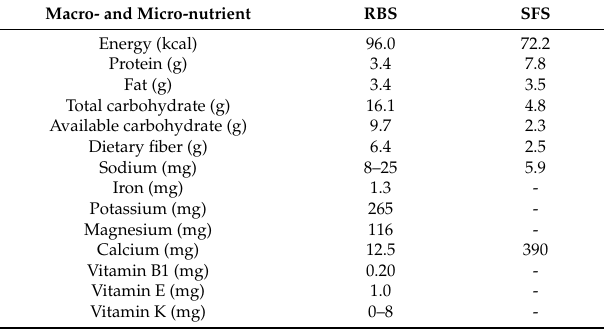
Table A1. Macro- and micro-nutrient composition of rice bran soymilk ( ρ = 104/100 g/mL ) and sugar-free soymilk per 195